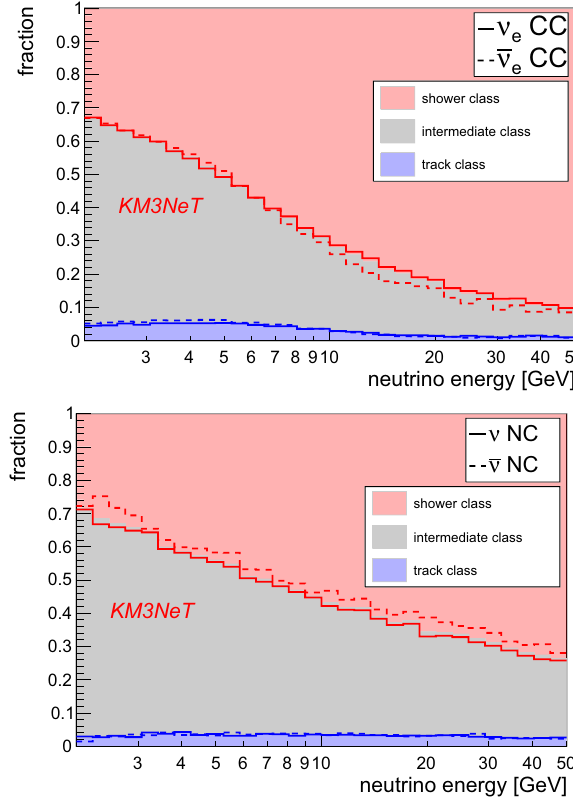
Fig. 6 Fractions of preselected neutrino events of different types that are classified in the track class, the intermediate class, and the shower class, as a function of true neutrino energy. The definition of the classes